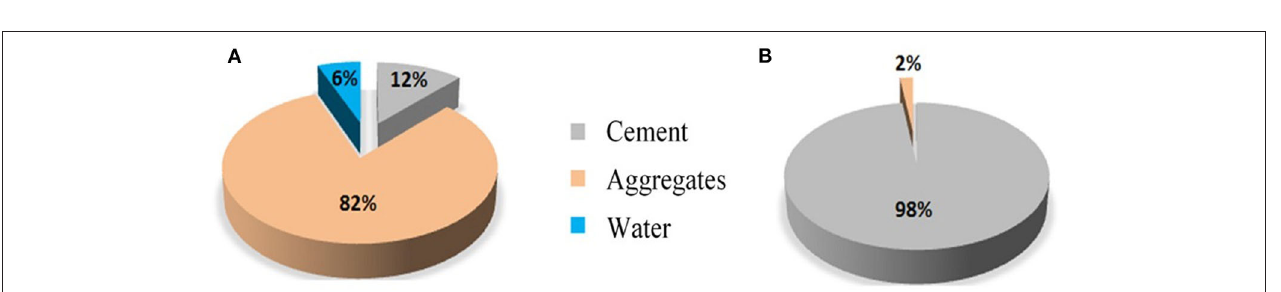
FIGURE 2 | Generic template for the ICM’s technological cycle inverse design problem.